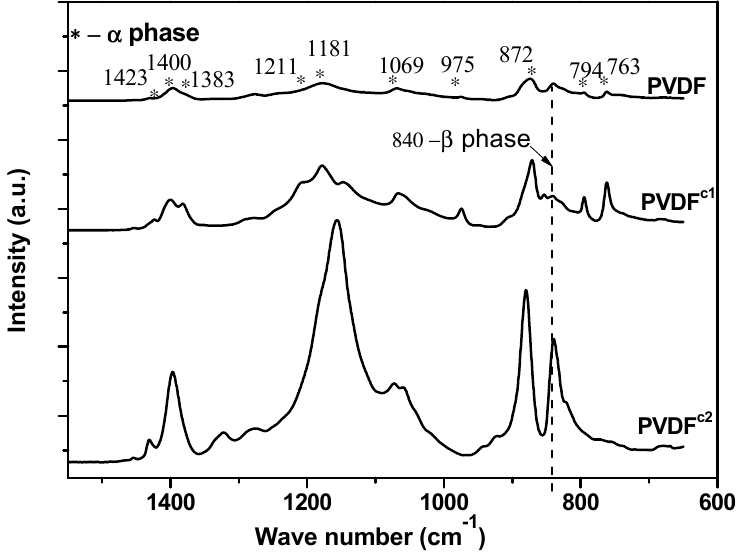
Figure 3. FTIR spectra of homer- and co-PVDF samples crystallizing from the melt.